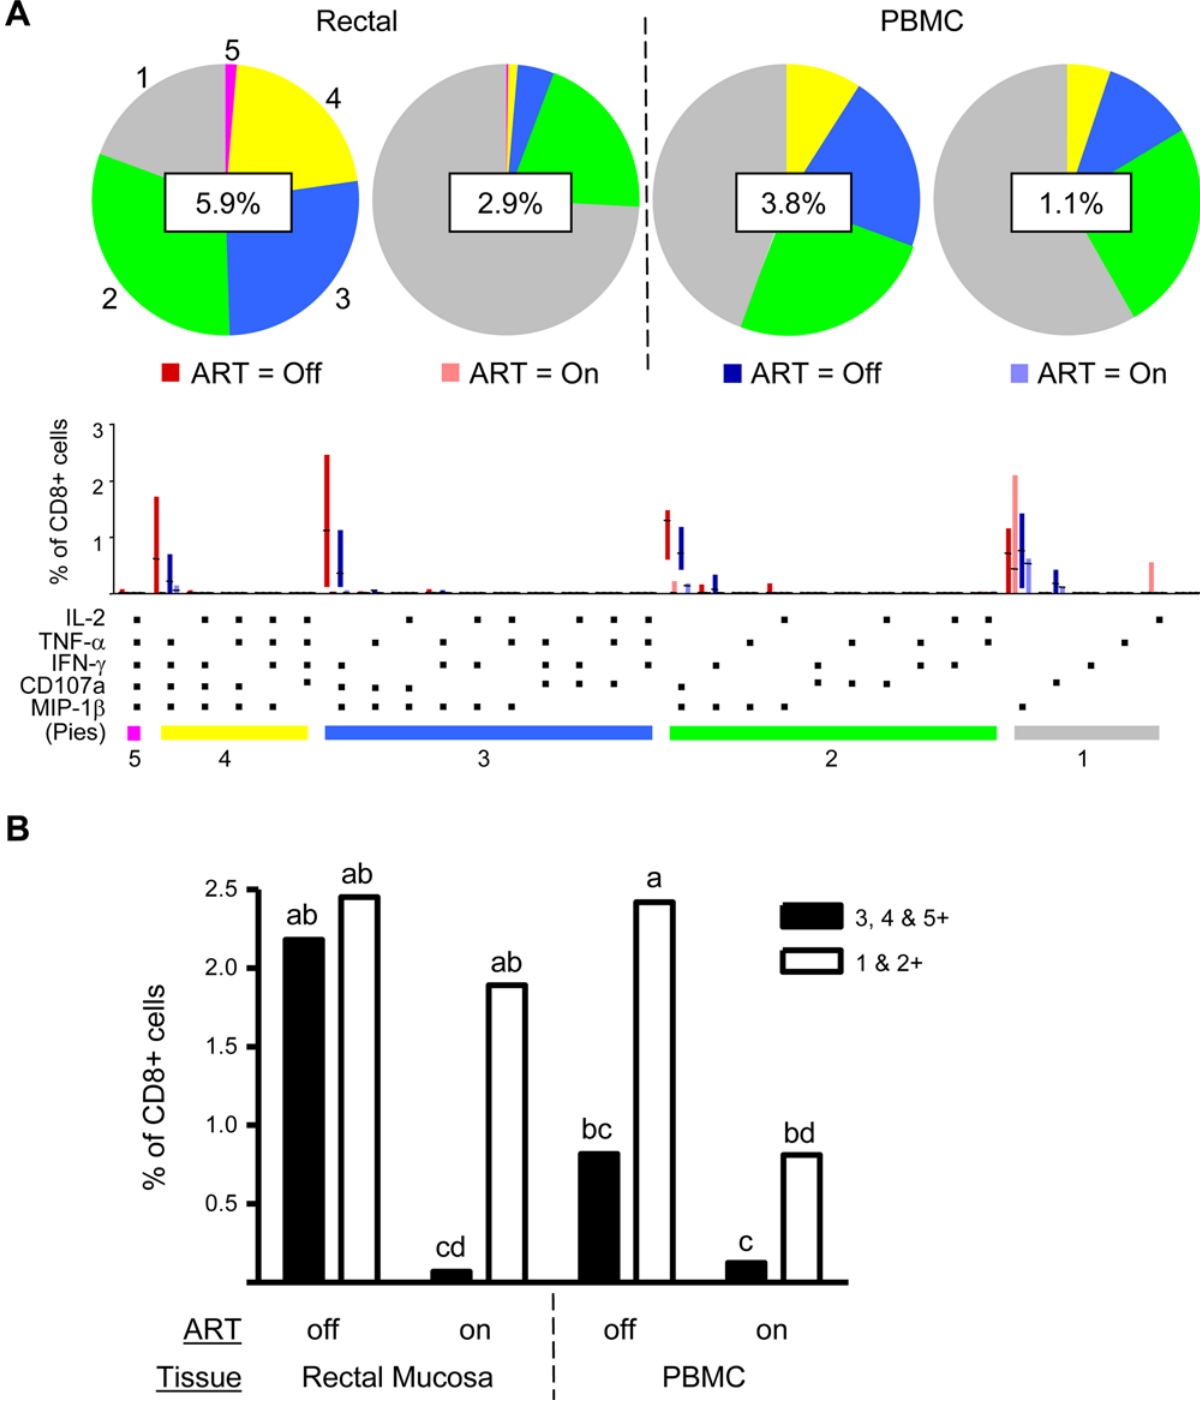
Figure 5. Detailed HIVgag response profile for CD8 + T-cells in rectal mucosa and blood. (A) Response profiles were generated using Boolean analysis of 5 functional response gates, resulting in 31 separate categories as described in the text. The percentage value shown in the center of each pie diagram denotes the total magnitude of CD8 + T-cells responding in any way (i.e., a summation across all 31 categories). Individual color- coded pie slices represent the fraction of cells within the total responding population displaying 5, 4, 3, 2, or 1 function(s), beginning at ‘12 o-clock’ and moving clock-wise, as compiled from the bar graph data. The bar graph provides fine detail on frequencies within each of the individual 31 categories; interquartile ranges and medians are shown. (B) Results from linear mixed model analysis of HIVgag-specific responses. ART status, tissue type, and polyfunctionality were treated as fixed effects (see Methods). Polyfunctional cells (open bars) were defined as cells positive for 3, 4, or 5 functions, and non-polyfunctional cells (closed bars) were defined as cells positive for 1 or 2 functions. Letters are statistical notations; bars that do not share a common letter are significantly different (p , 0.05).